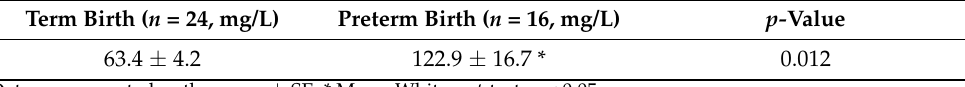
Table 2. Comparison of RBP levels between maternal blood of term and preterm birth .